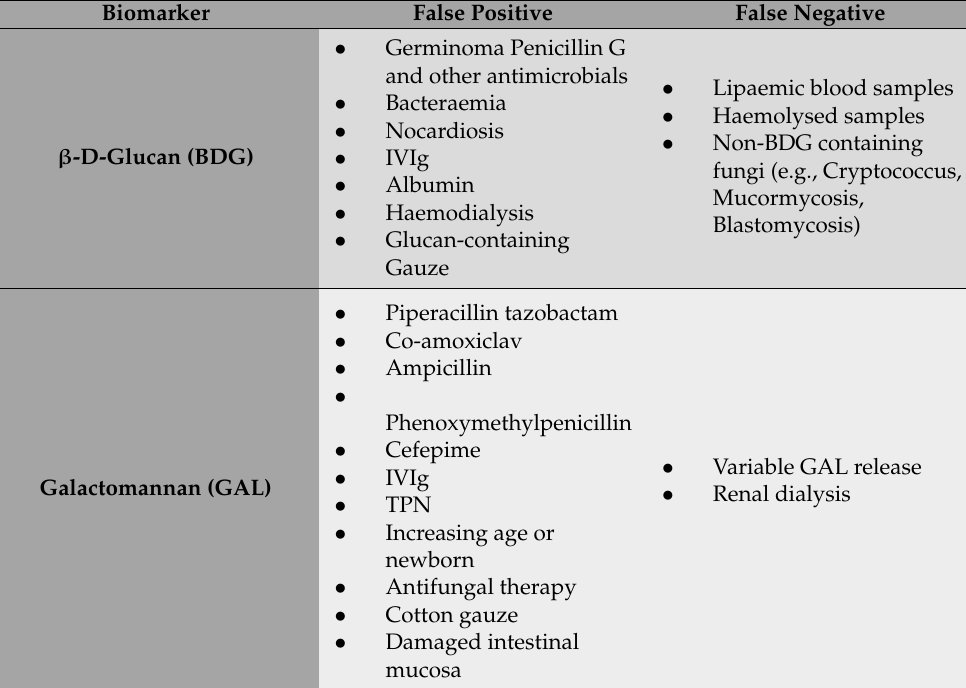
Table 2. False positive and false negative testing in serum fungal biomarkers [76–84]. Biomarker False